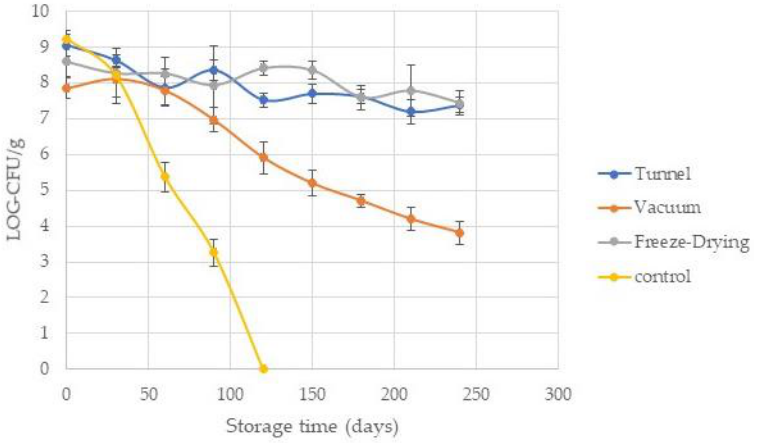
Figure 1. Survival rate (SR) after different methods of drying (tunnel, vacuum, and freeze drying) of F2. Fresh yogurt was used as control. Average of three repetitions. * Bars represents standard deviation. Different letters (a, b) are significantly different.